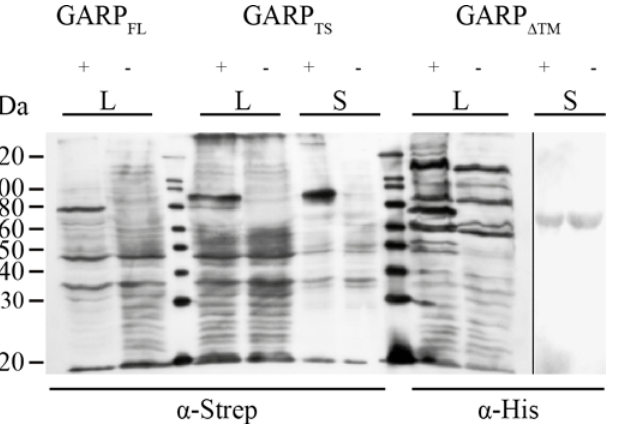
Fig 2. Transient Expression of the three recombinant GARP variants in HEK 293H cells. HEK 293H cells were transfected with plasmids containing the cDNA of the constructs GARP FL , GARP TS and GARP Δ TM , respectively. 48h after transfection, the culture medium was exchanged for FCS-free DMEM supplemented with NEAA. Supernatants (S) and cell lysates (L) were obtained after another 48h of incubation. 1 ml of supernatant was precipitated using 2% (w/v) Na-deoxycholate solution (1:100) and 100% TCA (1:10). Cell lysates were prepared using 200 μ l RIPA buffer per 1x10 6 cells. Samples were separated on a 10% PAA